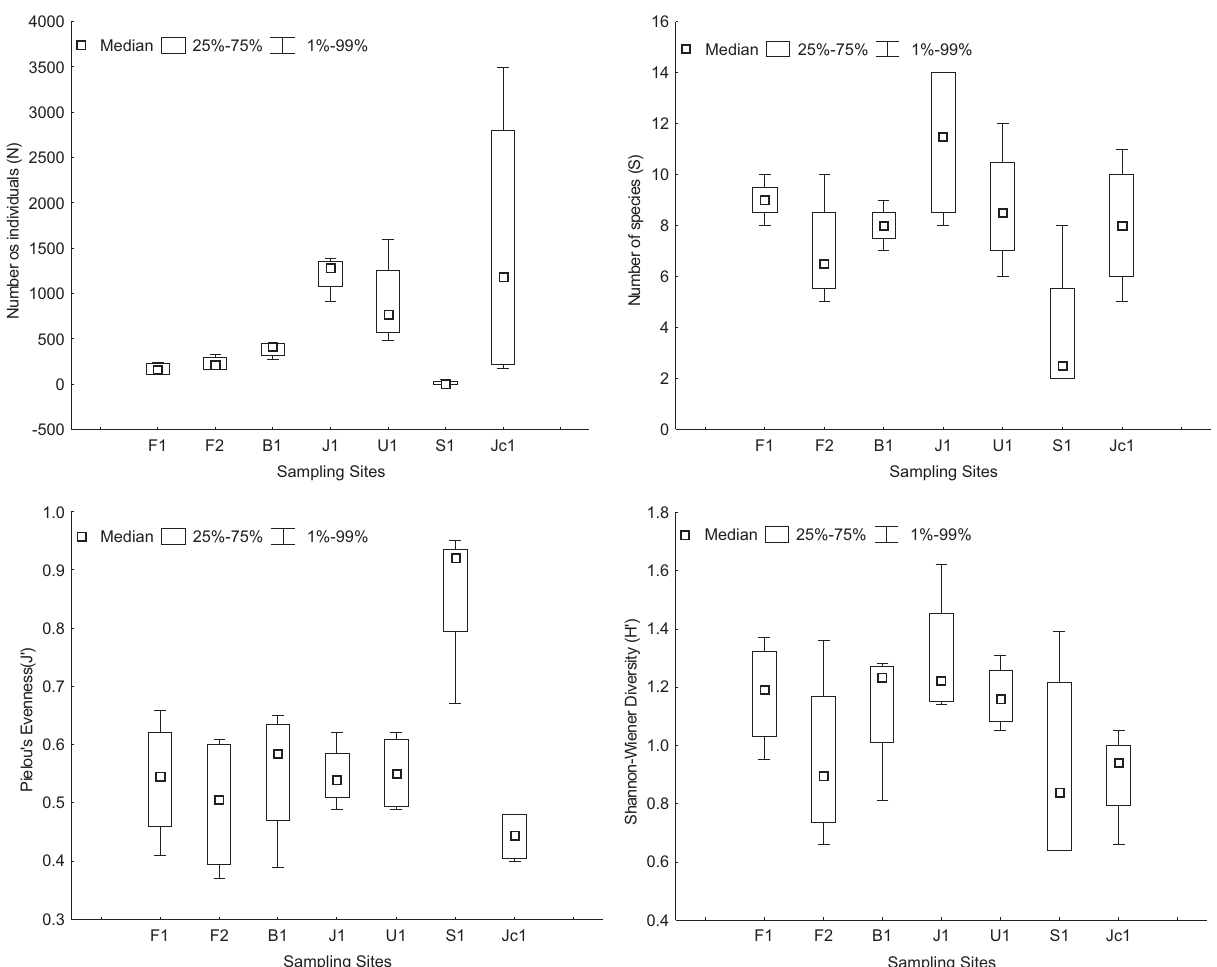
Figure 4. Frequency distribution of values of biological descriptors per sampling station in Saquarema-Jaconé lagoonal